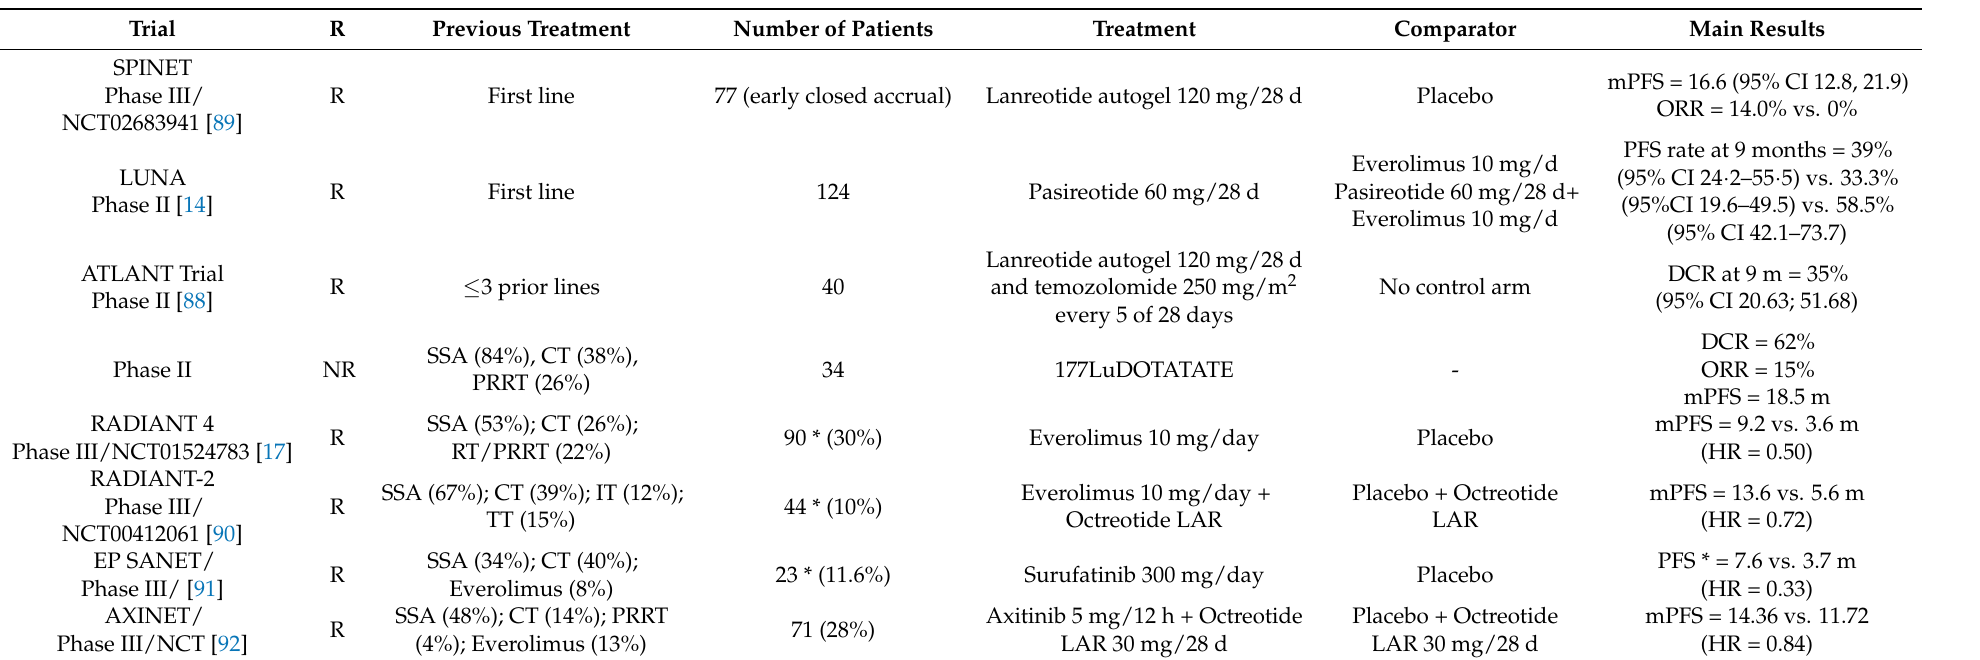
Table 2. Results of the main prospective clinical trials in advanced bronchial